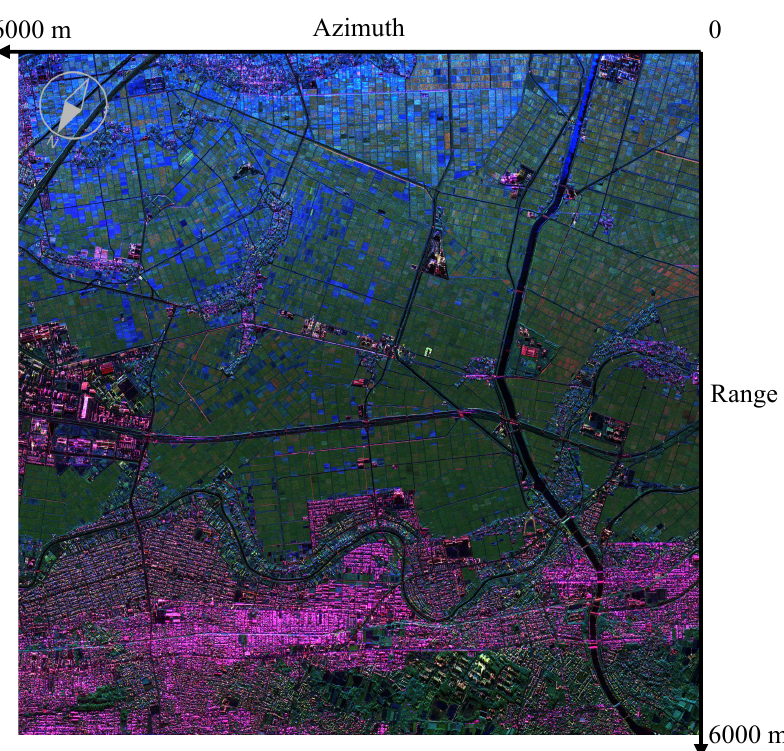
Figure 13. Another G4U image before calibration near Niigata Univ. on 25 August 2013 (Center: N37.852, E138.965).